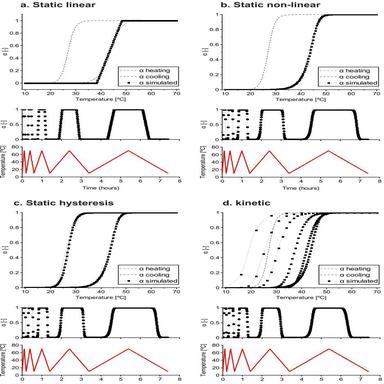
Simulations of phase transition models with temperature induced through a heating/cooling rate decreasing with time (10, 5, 2.5, 1 and 0.5 ◦C⋅min− 1 ). Simulation time step of 0.01 hour. First plot: predicted phase fractions (α) as a function of temperature. Second: predicted phase fractions (α) as a function of time. Third: temperature profile induced as a function of time.